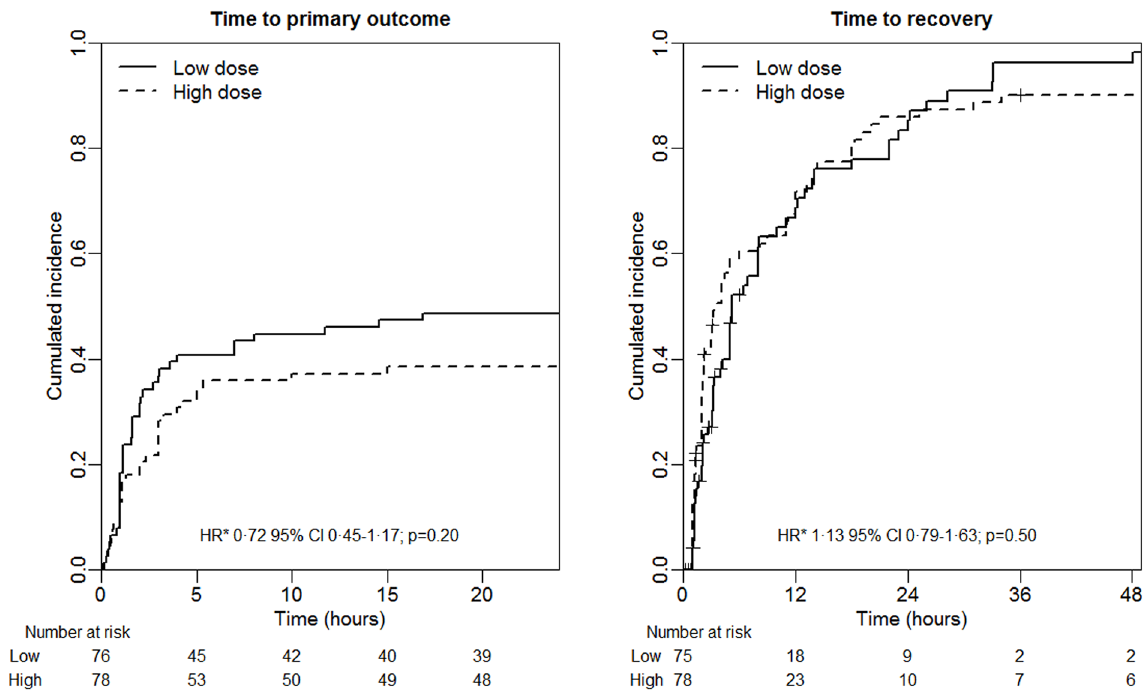
Fig 2. Cumulative incidence by study arm for primary outcome 1 (left panel) and recovery 2 (right panel) obtained with Kaplan-Meier survival estimator in 154 patients (modified intent-to-treat population). https://doi.org/10.1371/journal.pntd.0005612.g002 treatment with no difference between high 42/78 (54%) vs. low dose 40/76 (53%) groups